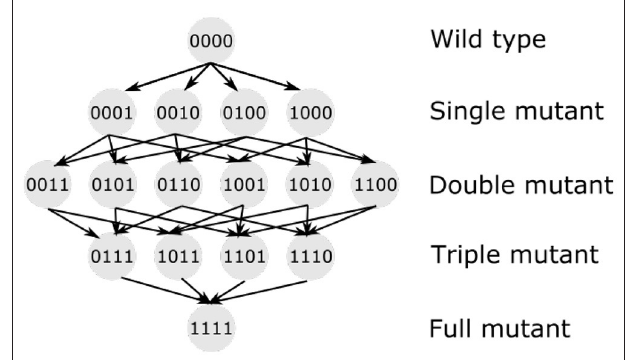
FIGURE 9 | Evolutionary paths from a wild type to a full mutant. When four loci are considered, a wild type can mutate into four different single mutants, which, in turn, can mutate into three double mutants each, altogether six double mutants. Then the opportunity to mutate is reduced, with only four triple mutants available. Each has only one possible mutation left, converging into a single strain of full mutant. Circles with numbers—different genotypes (0—sensitive, wild-type, 1—resistant, mutated allele). Arrows show the direction of mutations present in the